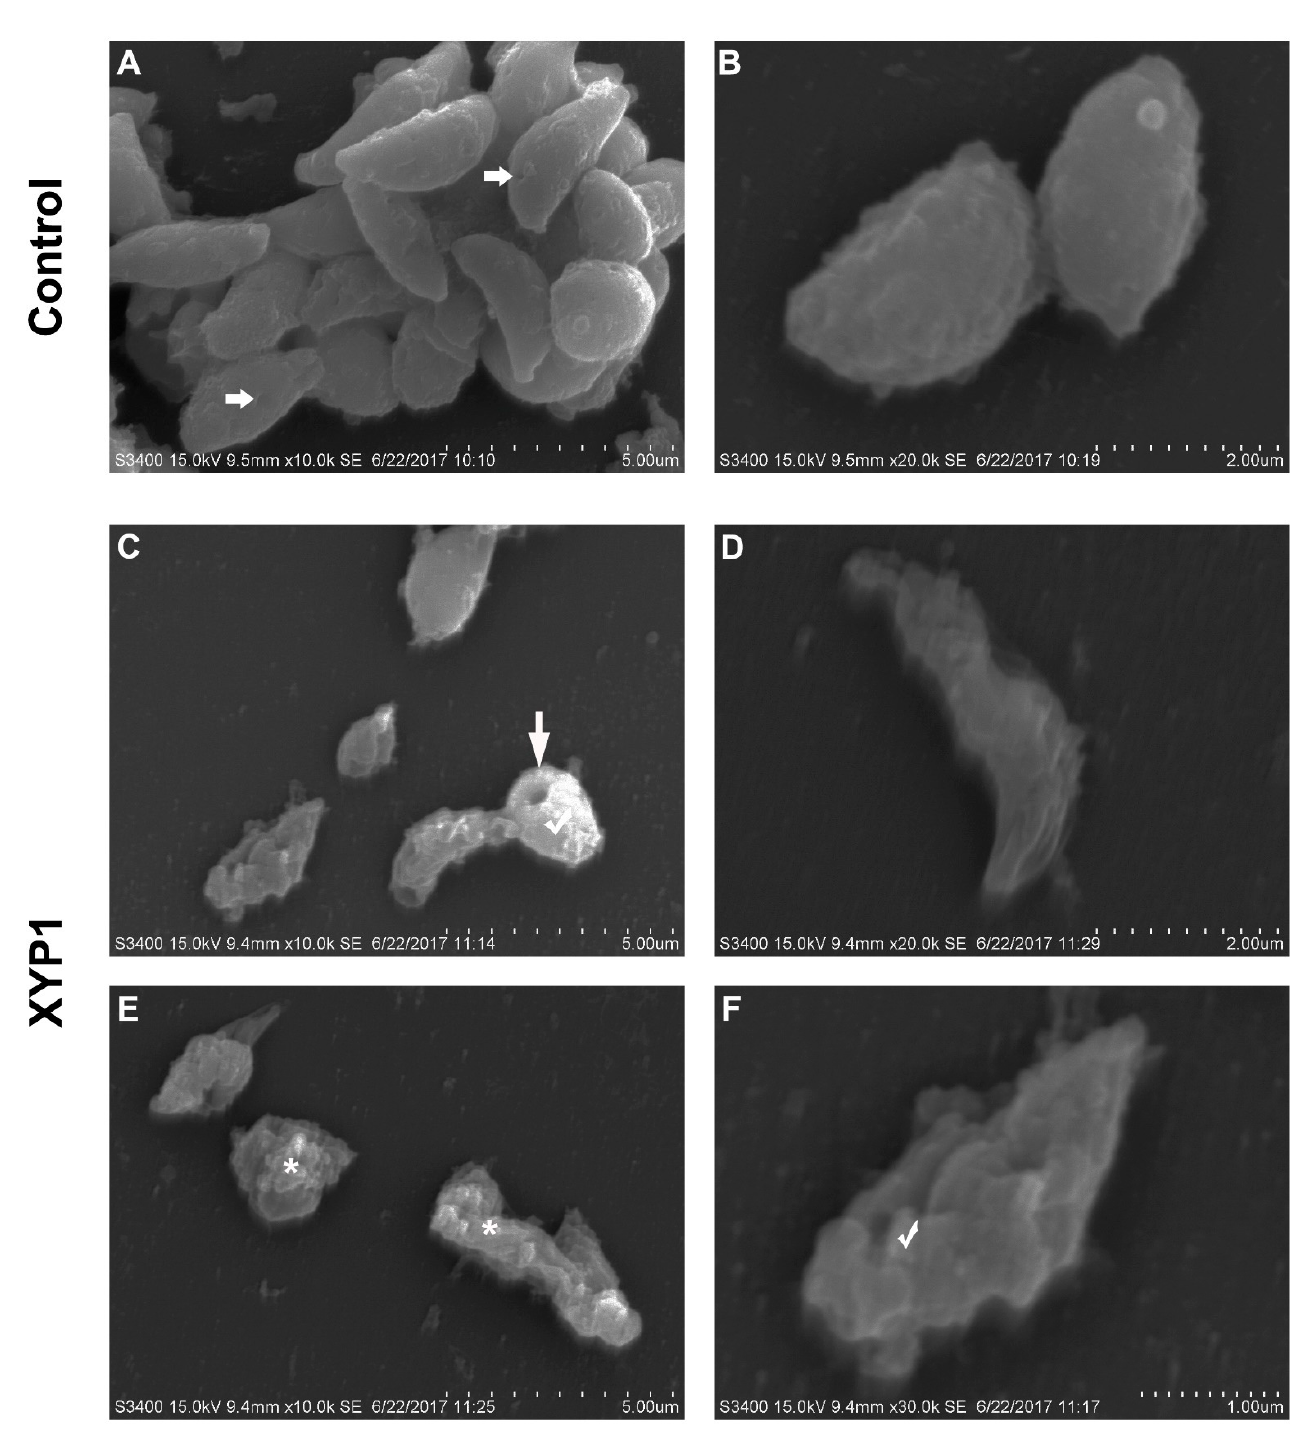
Figure 5. Morphological changes of T. gondii tachyzoites treated with XYP1 as visualized by SEM. Parasites treated with DMEM were defined as the negative control ( A , B ). Parasites were exposed to 10 μ M XYP1 for 2 h ( C – F ). Markers: horizontal arrows ( → ) in A: primary portal of tachyzoites; vertical arrow ( ↓ ) in C: hole of tachyzoites; asterisk (*) in E: disintegrated tachyzoites; hooks ( √ ) in c and F: swelled tachyzoites. Scale bars = 5 μ m ( A , C , E ); 2 μ m ( B , D ); 1 μ m ( F ).